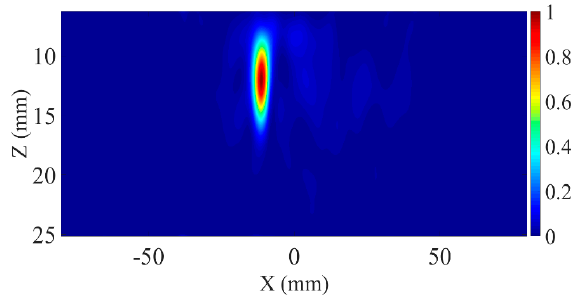
Figure 9. Reconstructed mm-wave image for Test 3 .